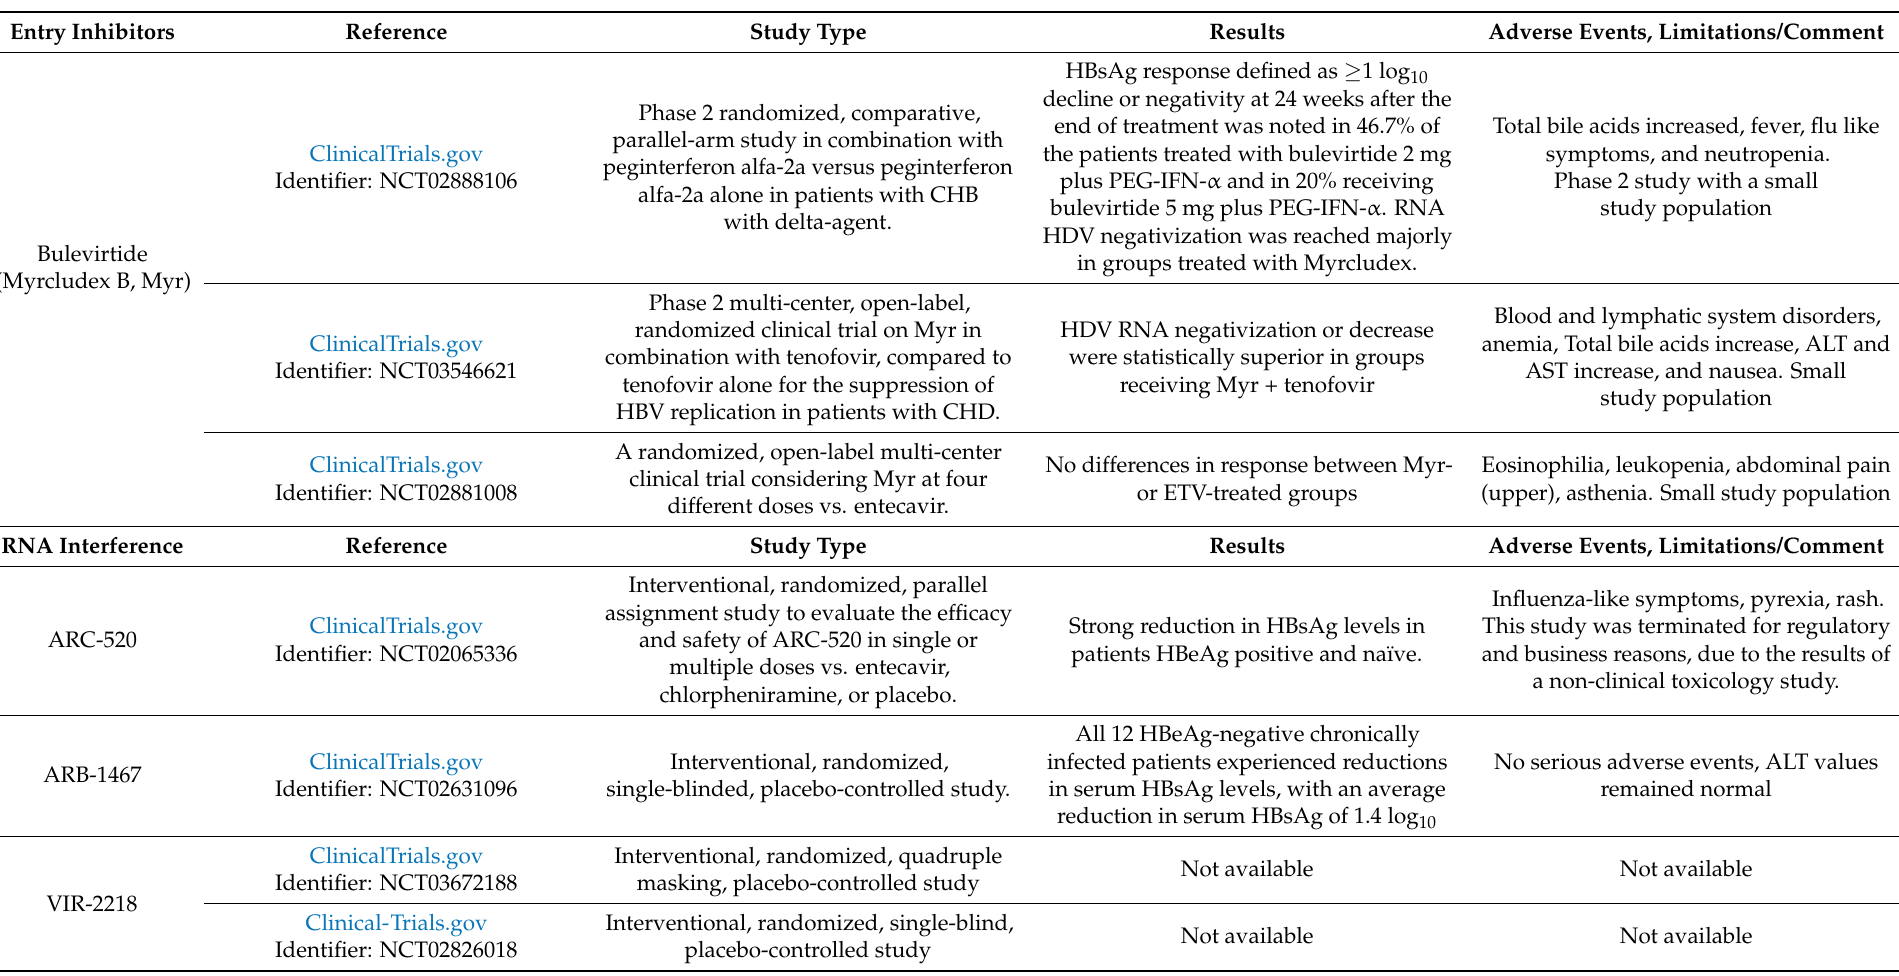
Table 1. Principal clinical trials evaluating new direct antiviral agents. PEG-INF: pegylated interferon alpha; Myr: Myrcludex; ETV: entecavir; CHB: chronic hepatitis B; CHD: chronic hepatitis D; TDF: tenofovir disoproxil fumarate; TAF: tenofovir alafenamide; RNA: ribonucleic acid; DNA: deoxyribonucleic acid; BSV: besifovir; HBsAg: hepatitis B surface antigen; HBeAg: hepatitis B e antigen; HBV: hepatitis B virus; HDV: hepatitis D virus; ALT: alanine aminotransferase; AST: aspartate aminotransferase; pgRNA: pre-genomic ribonucleic